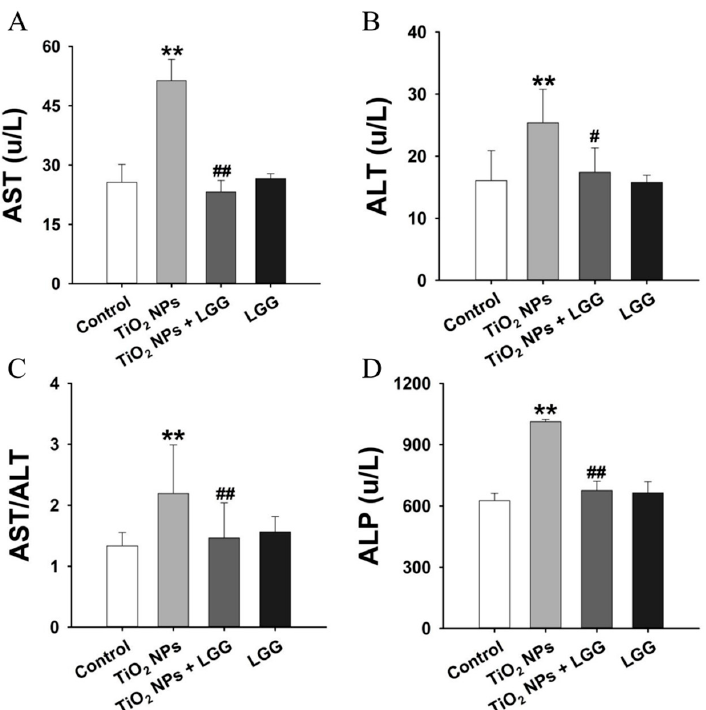
Figure 4. Serum biochemical analysis after oral administration of TiO 2 NPs in the young rats. ( A ) aspartate aminotransferase, AST. ( B ) alanine aminotransferase ALT. ( C ) The ratio of AST to ALT. ( D ) alkaline phosphatase, ALP. ** p < 0.01 versus the control group; # p < 0.05 and ## p < 0.01 versus the TiO 2 NPs group. n = 3, values are presented as mean ± SD.